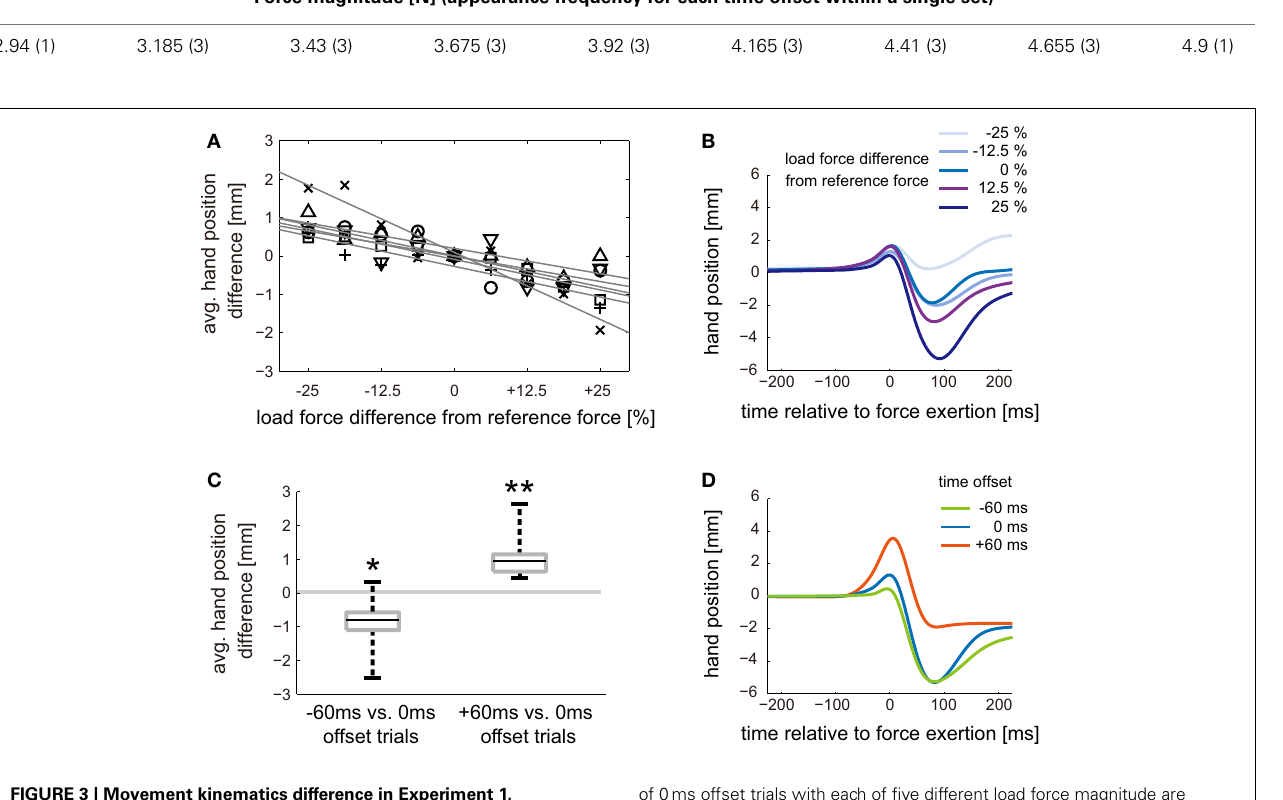
FIGURE 3 | Movement kinematics difference in Experiment 1. (A) Trajectory difference caused by difference in load force magnitude. Hand trajectory data are aligned at the time of load force exertion and averaged within the trials with the same combination of time offset and load force magnitude.The difference between average hand trajectory of 0ms offset with 3.92N force and that of 0ms offset with other force magnitude was assessed by averaging hand position difference from 200ms before to 200ms after the load force exertion. Shape of markers represents participant.The gray solid lines are linear regressions of each marker.The negative value in trajectory difference means that the hand was on average below the reference trajectory. (B) Typical hand trajectories for different load force magnitude. Average hand trajectories